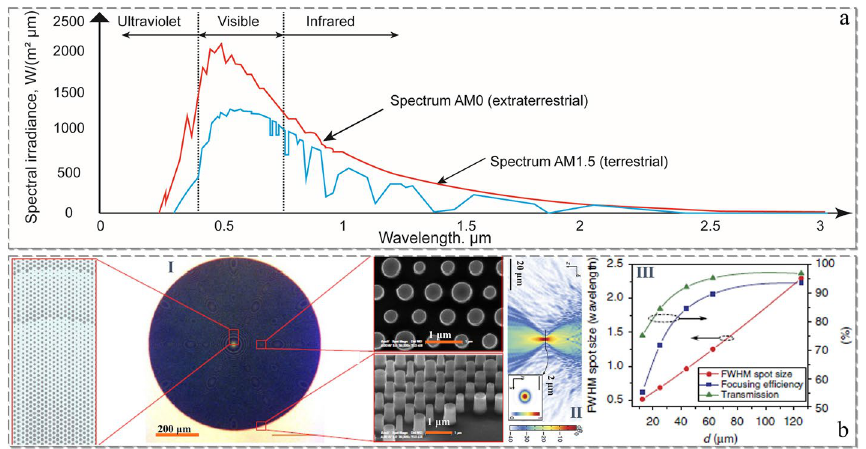
Fig. 5 (a) Conceptual depiction of the spectrum of solar irradiance, i.e., the power density of solar radiation as a function of wavelength. (b) Schematic of the aperiodic HCTA lens (left panel of b(I)), optical microscopy image of a fabricated HCTA lens (middle panel of b(I)), and SEM images (right panel of b(I)) of the Si posts that form the HCTA lens. b(II) Logarithmic scale electric energy density at the plane of focus. b(III) Measured plane of focus FWHM spot size, transmission, and focusing efficiency of the HCTA micro-lens as a function of focusing distance. (a) Reproduced with permission [18]. Copyright 2021, published by Springer Nature. (b) Reproduced with permission [175]. Copyright 2015,